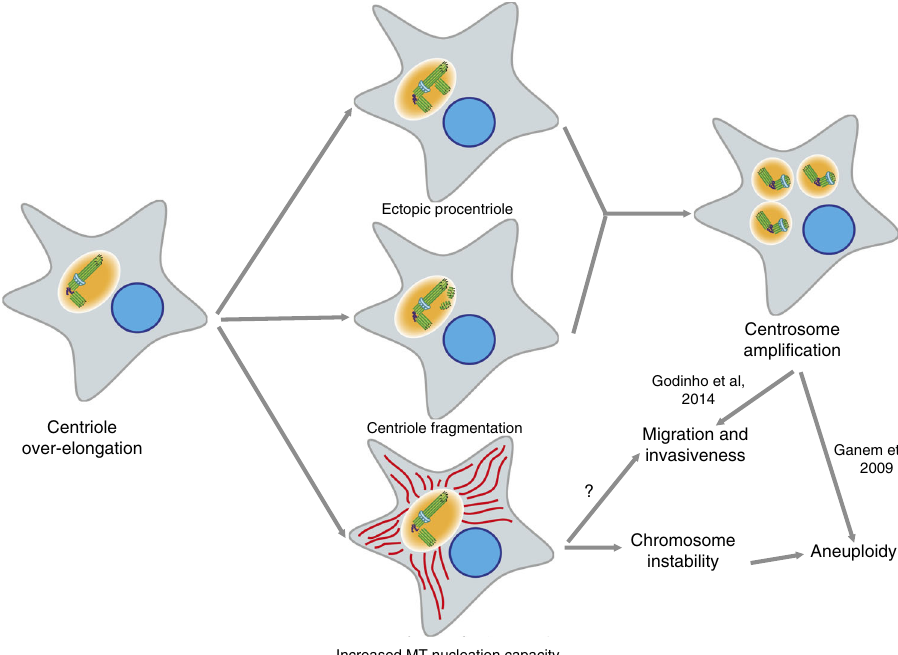
Fig. 7 Cellular consequences of centriole length deregulation. In cancer cells, over elongated centrioles induce centriole ampli fi cation through centriole fragmentation and/or ectopic procentriole formation along the elongated centrioles. Elongated centrioles also generate larger MTOCs with a higher capacity to nucleate MTs that enhance chromosome instability during mitosis. Both scenarios could give rise to aneuploidy and might as well induce invasiveness, therefore centriole length deregulation might participate to tumour initiation and